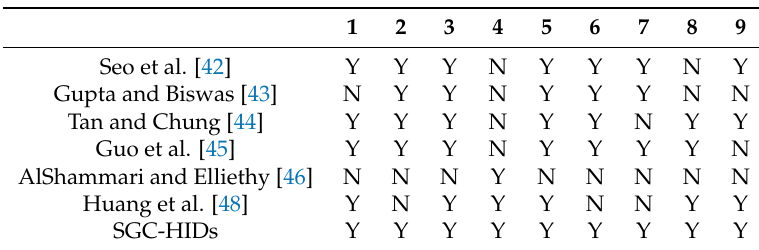
Table 2. Main features in SGC.